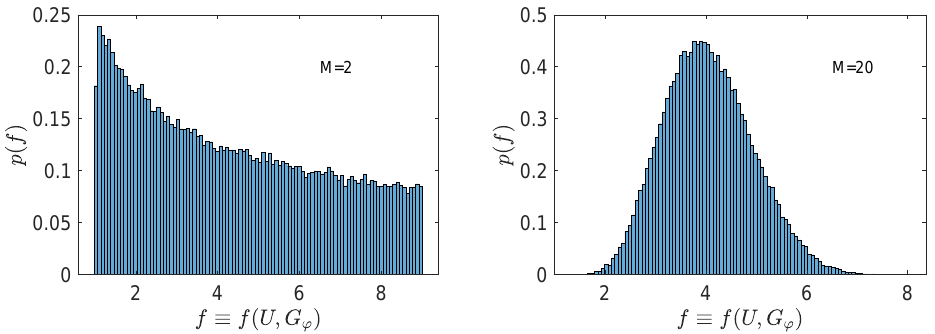
Figure 2. Histograms of the pre-factor f ( U , G ϕ ) in Equation (13) for M = 2 ( left ) and M = 20 ( right ), obtained numerically with 10 5 samplings of U with respect of the unitary Haar measure [36]. The generator G ϕ chosen is a diagonal matrix with half 1s and half 3s as entries. The histograms are normalized to the unity. We can see that in the histogram in the right, the values of the pre-factor are [ f ( U , G ϕ )] more concentrated around its average E (cid:39) P